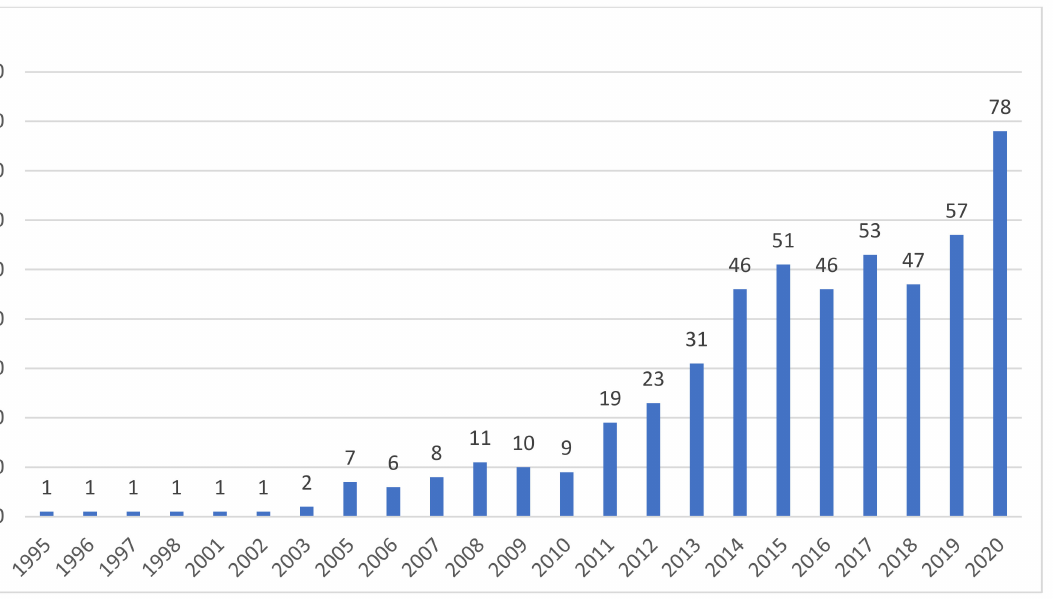
Figure 3. Number of documents per